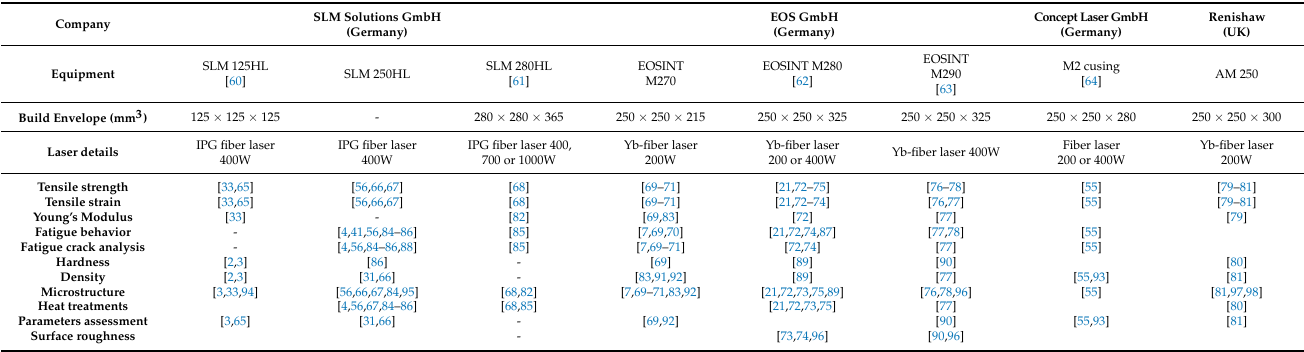
Table 2. Summary of studies addressing Ti6Al4V parts produced by LPBF.